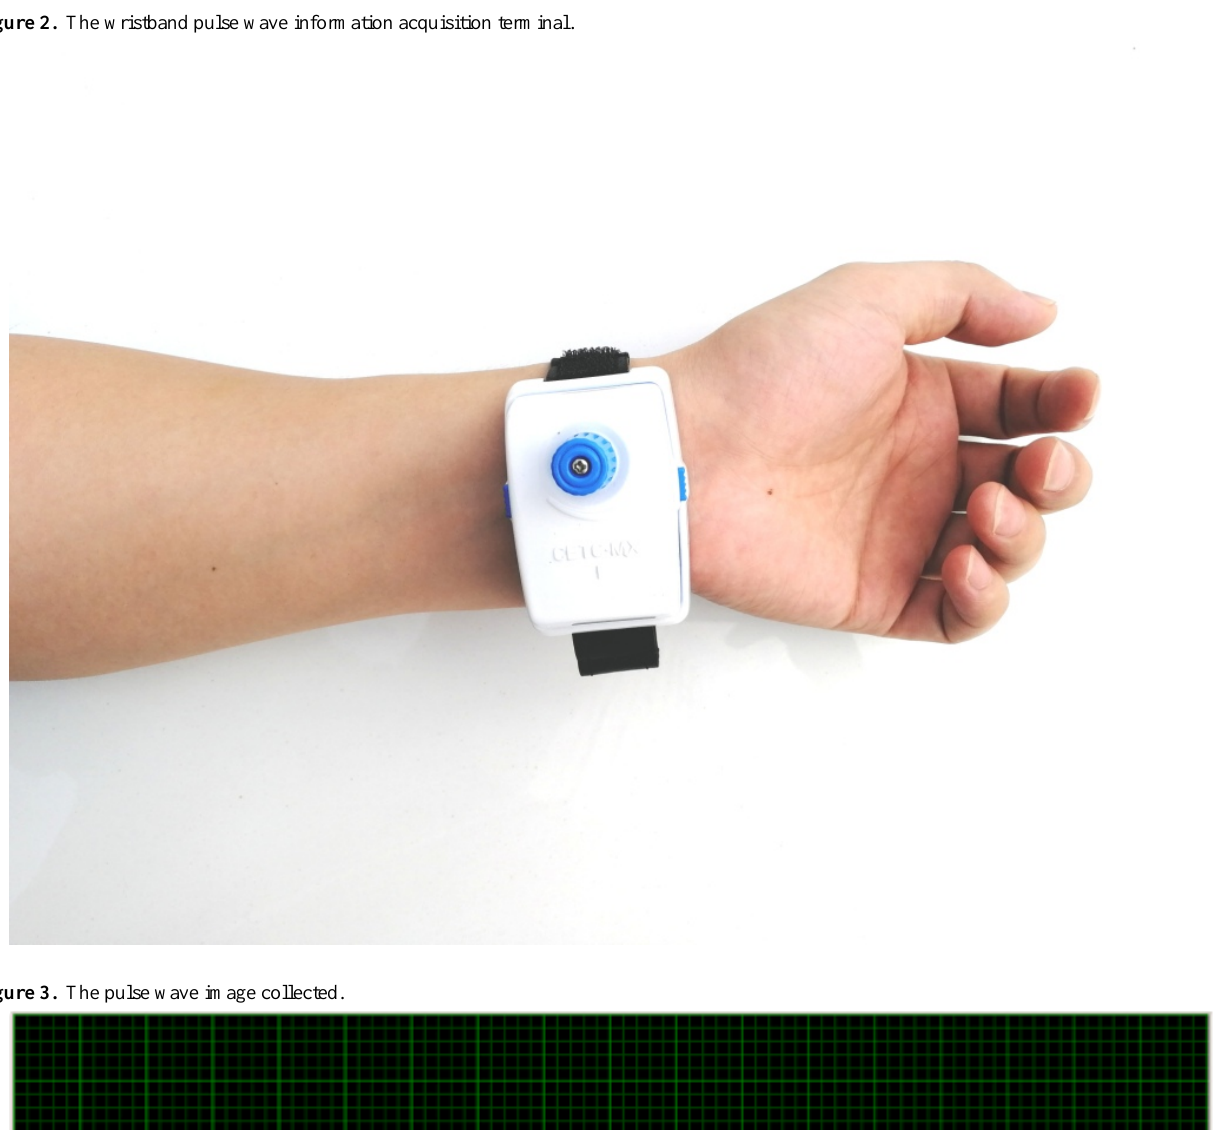
Figure 2. The wristband pulse wave information acquisition terminal.